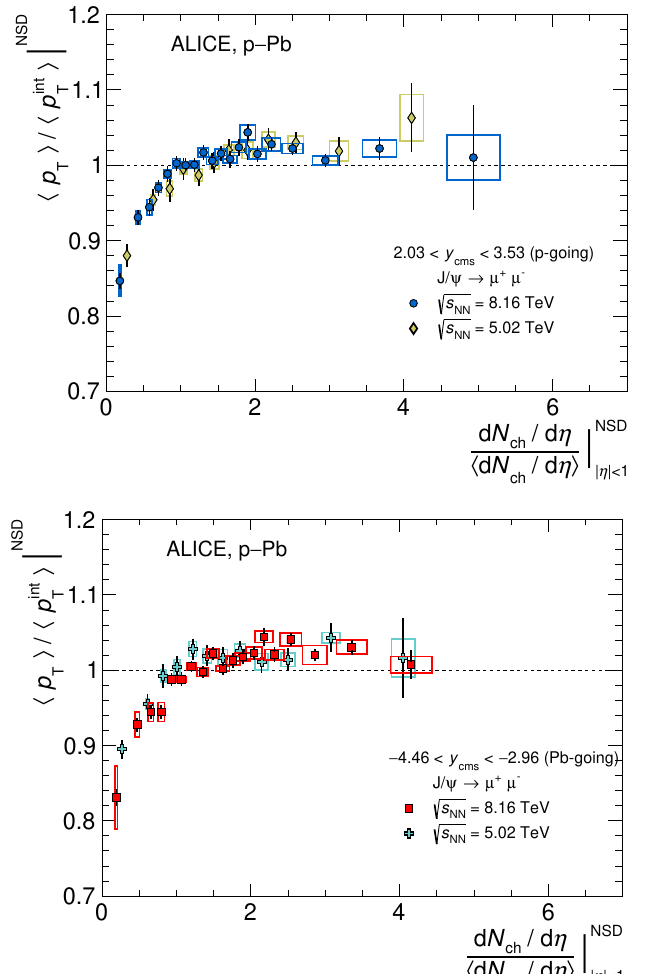
Figure 7 . Normalized average transverse momentum of inclusive J = as a function of the nor- malized charged-particle pseudorapidity density, measured at midrapidity, in p-Pb collisions at p p s NN = 8 : 16 TeV and s NN = 5 : 02 TeV [26]. Top (bottom) panel presents the measurement at forward (backward) rapidity. The vertical bars represent the statistical uncertainties, the boxes the systematic